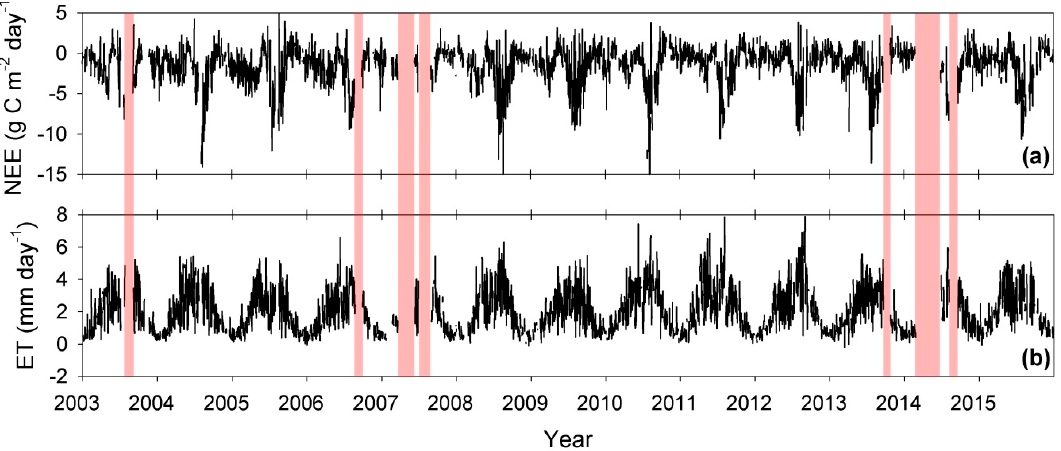
Figure 1. Time series of daily net ecosystem exchange (NEE) of CO 2 ( a ) and evapotranspiration (ET) ( b ) for the HFK site. The daily fluxes were calculated by averaging all available data in a day (not gap-filling). Shaded areas indicate the long gaps (i.e., gaps longer than 30 days) over the study period.